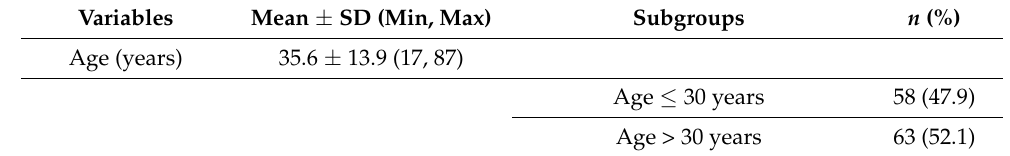
Table 1. Demographic and clinical characteristics of the participants ( n =